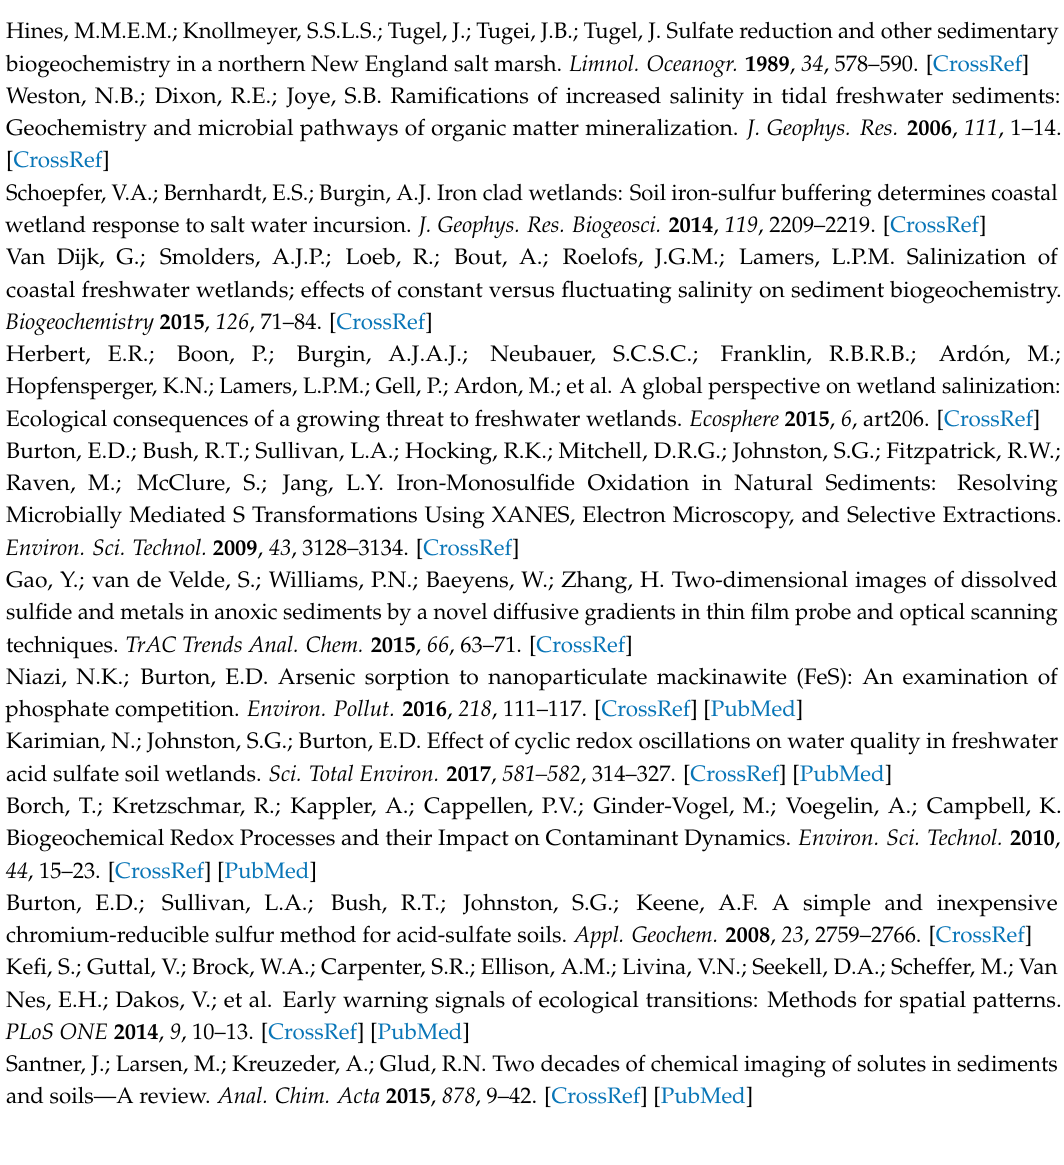
R code S1: Variogram building, Figure S1: FeS spatial distribution and standards, Figure S2: Example image flow, Figure S3: Example nugget effects. Figure S4: The area per complex per month and distance. Figure S5: Histogram of one plate’s pixel by pixel concentrations and their respective